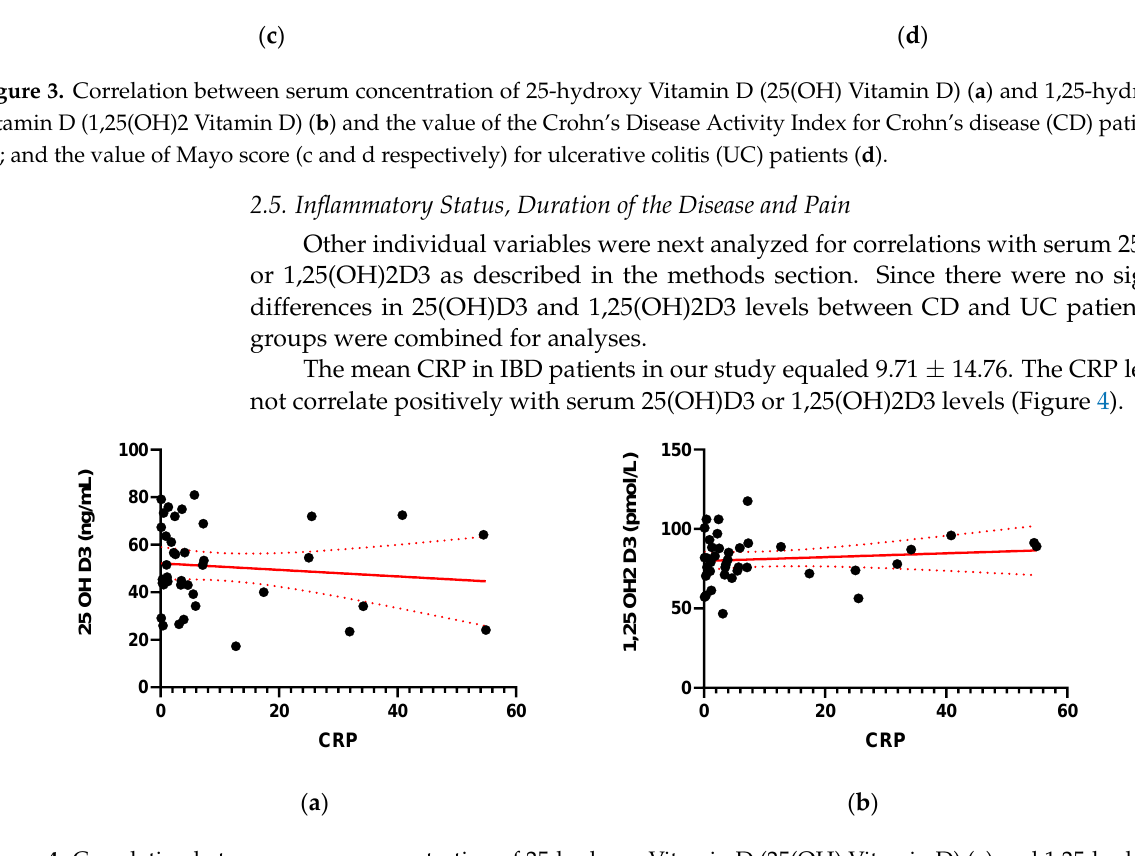
Figure 4. Correlation between serum concentration of 25-hydroxy Vitamin D (25(OH) Vitamin D) ( a ) and 1,25-hydroxy Vitamin D (1,25(OH)2 Vitamin D) ( b ) and the levels of C-reactive protein (CRP) in IBD patients.